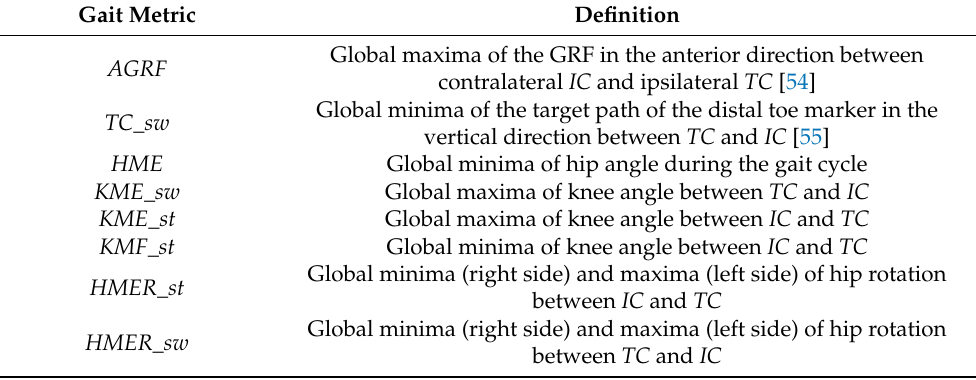
Table 1. Definition of gait metrics.